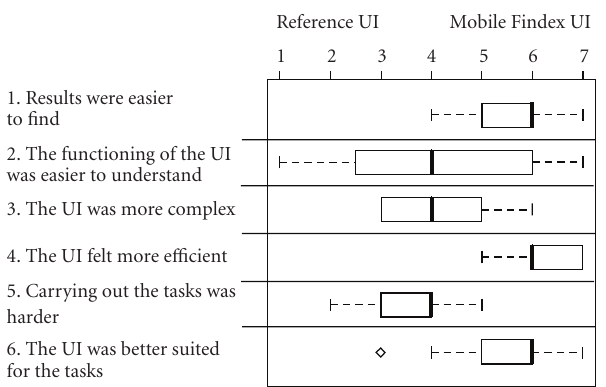
Figure 5: Subjective ratings comparison between the Reference UI and Mobile Findex